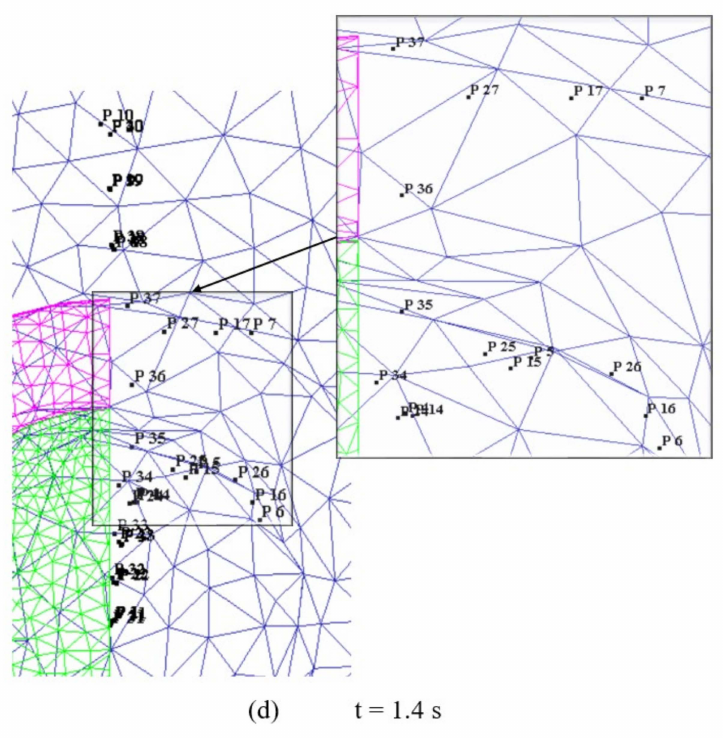
Figure 12. Point tracking positions representing material movement during plunging stage: ( a ) Front view − 0.7 s; ( b ) Front view − 1.4 s; ( c ) Top view − 0.7 s; ( d ) Top view − 1.4